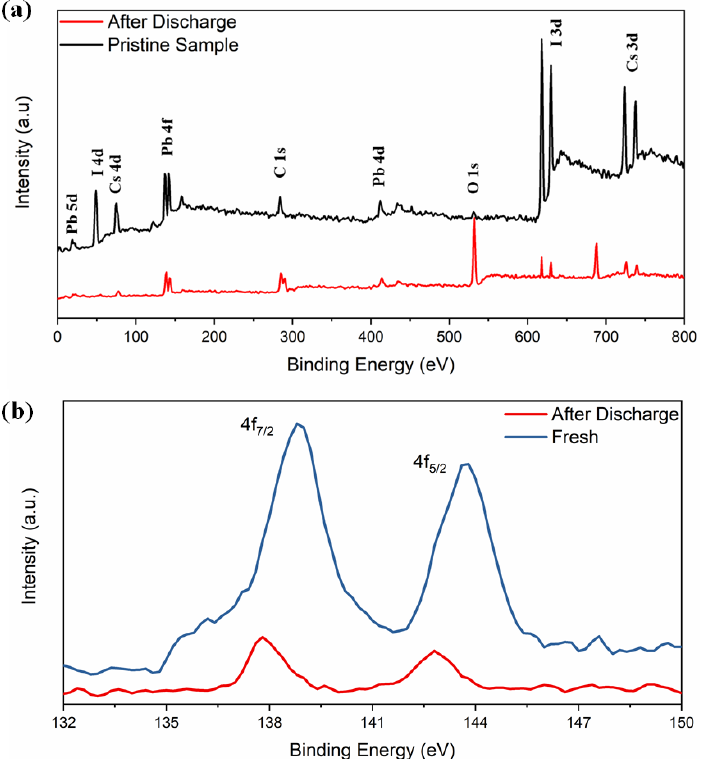
Figure 4. ( a ) Full scan XPS spectra of CsPbI 3 , ( b ) XPS spectra of Pb 4f before and after electrochemical discharging process.